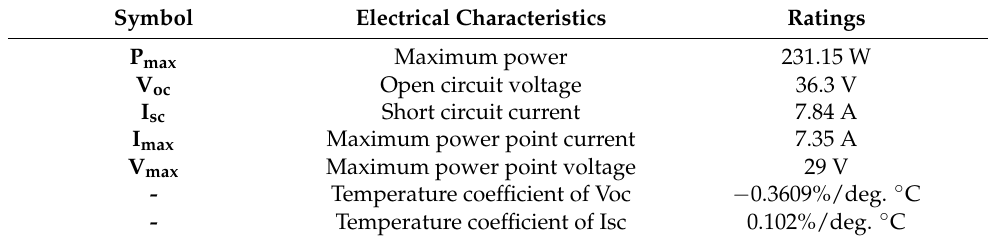
Table A1. PV Module electrical